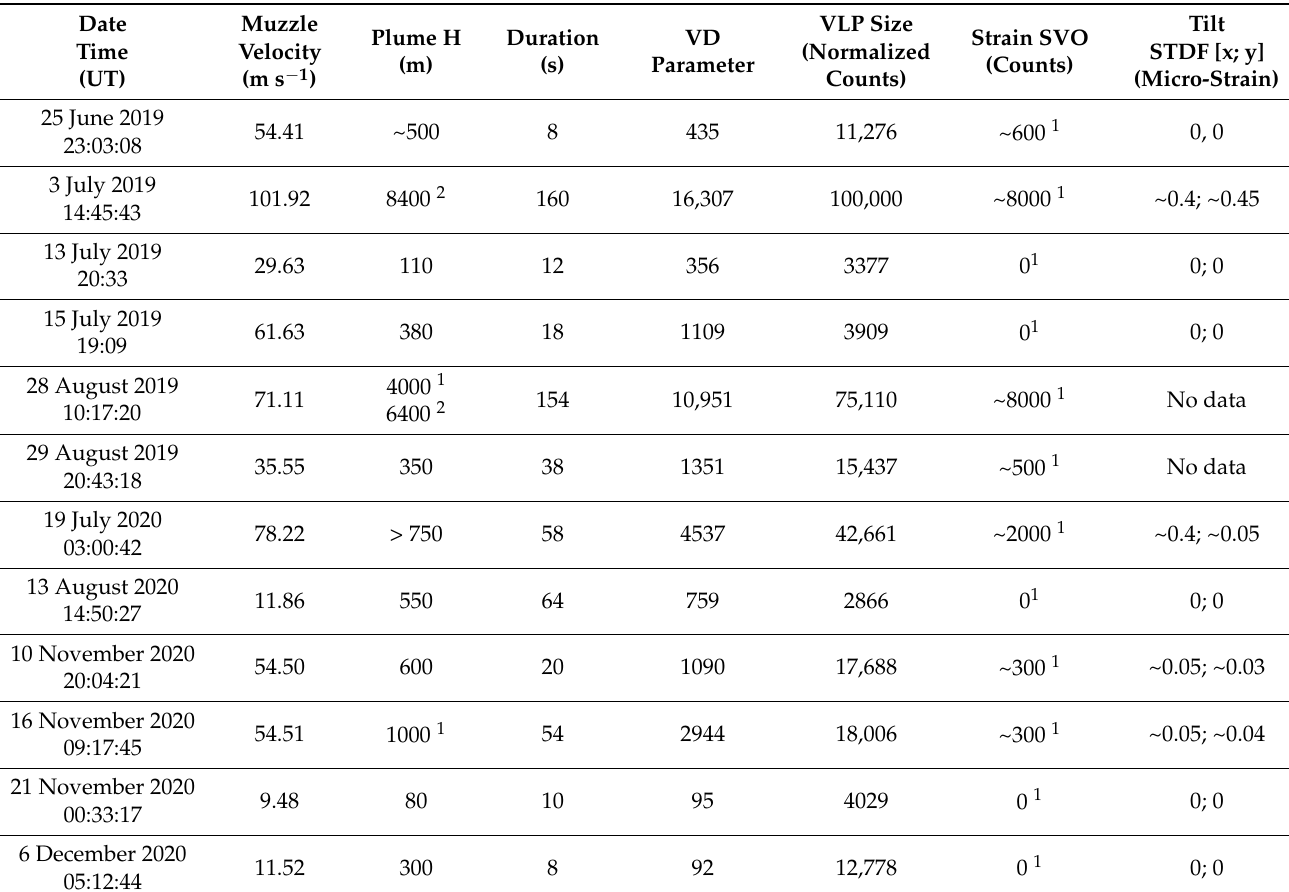
Table 4. Multi-parametric measurements of the 12 explosions considered as case studies useful for their classification. The duration of each event and its muzzle velocity are obtained from the SQV camera monitoring videos. Plume height (H) is considered above crater rim and measured from the fixed monitoring cameras or reported (where specified) from references. See text for further